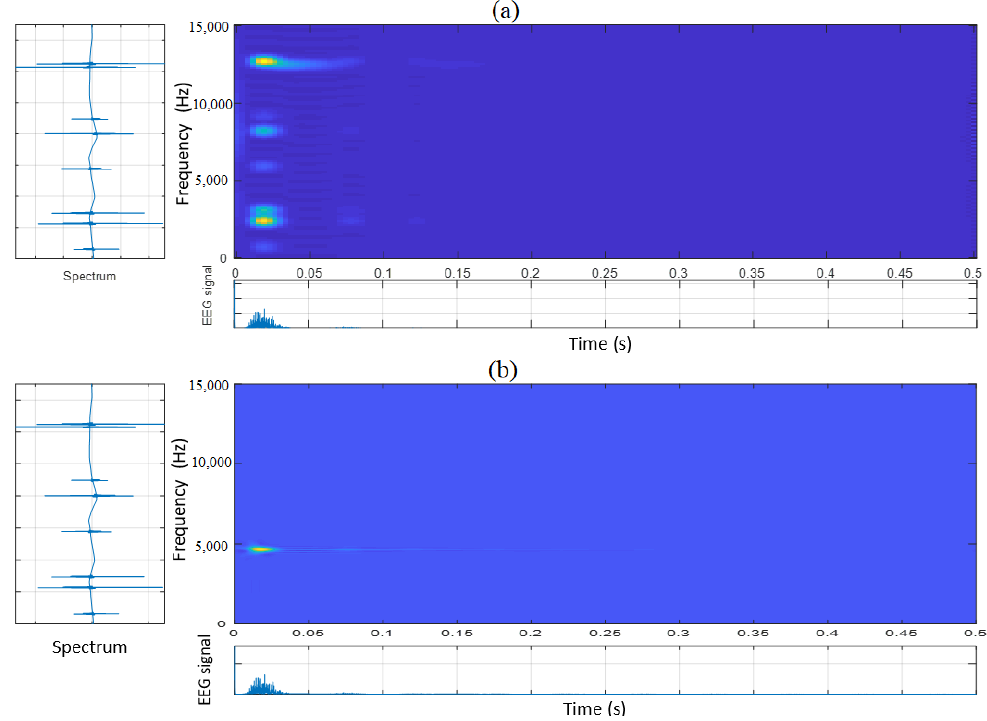
Figure 3. A practical example of Choi-Williams decomposition (QTFD) of EEG